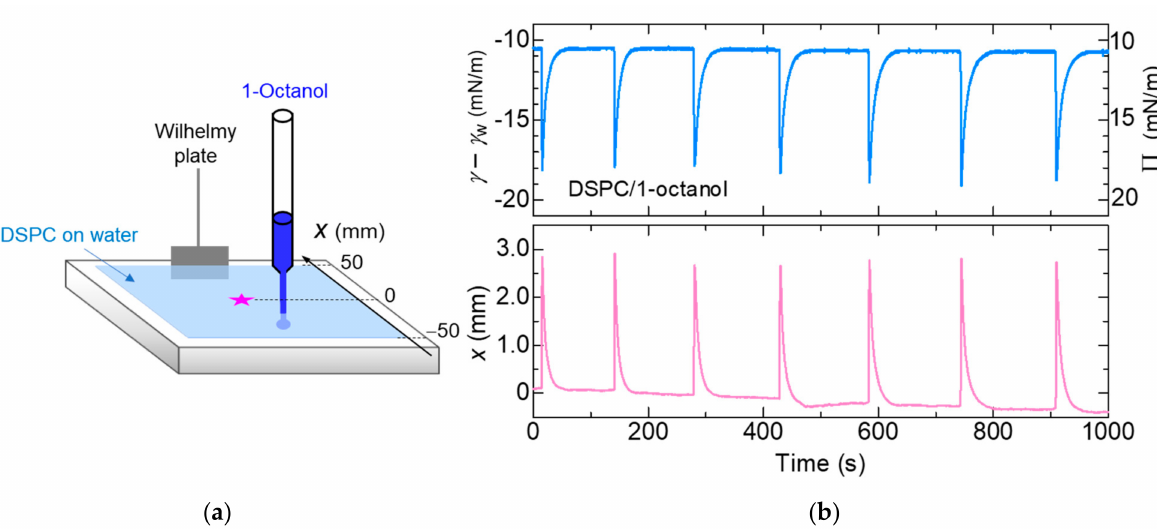
Figure 1. ( a ) Experimental setup. The surface tension is measured using a Wilhelmy plate. The motion of the tracer particle made of polyethylene terephthalate placed on the center of the trough was observed to visualize the Marangoni convective flow.; ( b ) Oscillations of surface tension compared with the movement of a tracer particle. The movement of the particle was exactly synchronized with the abrupt decrease in the surface